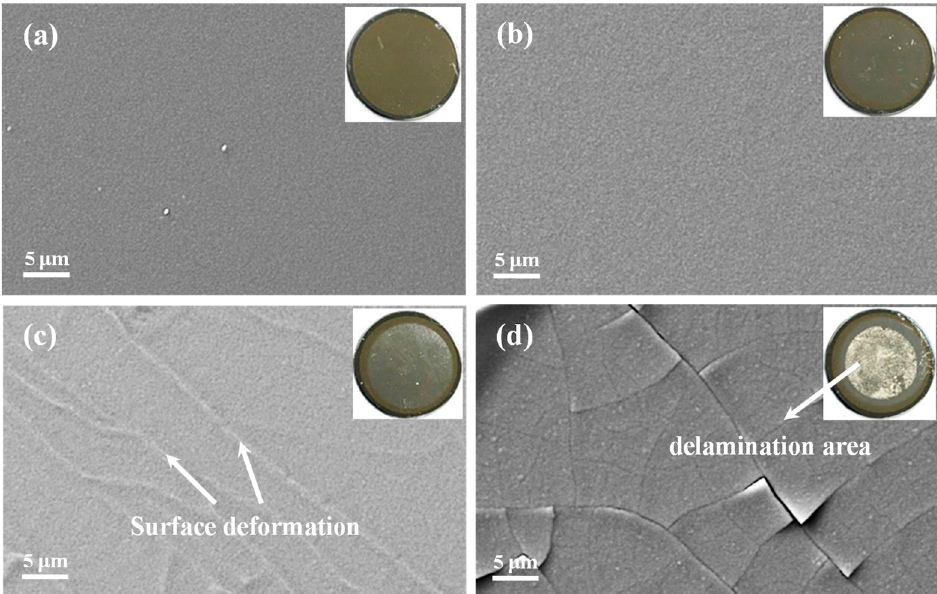
Figure 1. SEM and optical microscopic images of as-grown Si/Mo/Ti multilayer films with different Mo transition layer thicknesses for ( a ) Mo-1, ( b ) Mo-2, ( c ) Mo-4, and ( d ) Mo-8. The Mo-1 and Mo-2 samples exhibited smooth surfaces while the Mo-4 sample started to display surface deformation and the Mo-8 sample showed obvious surface delamination.